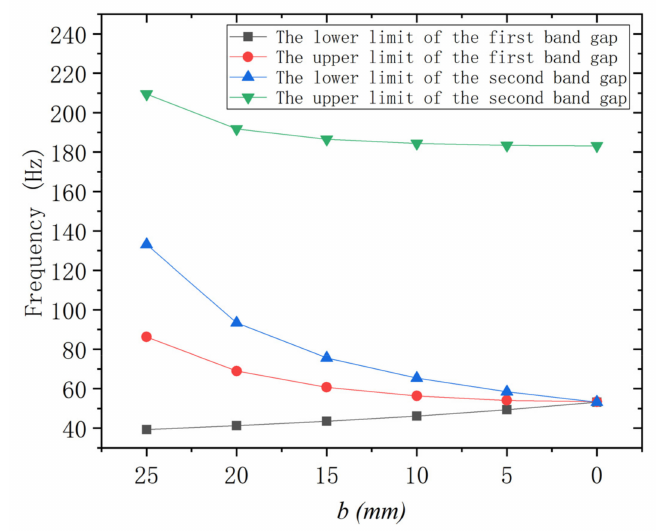
Figure 11. The impact of the partition location on band gap.